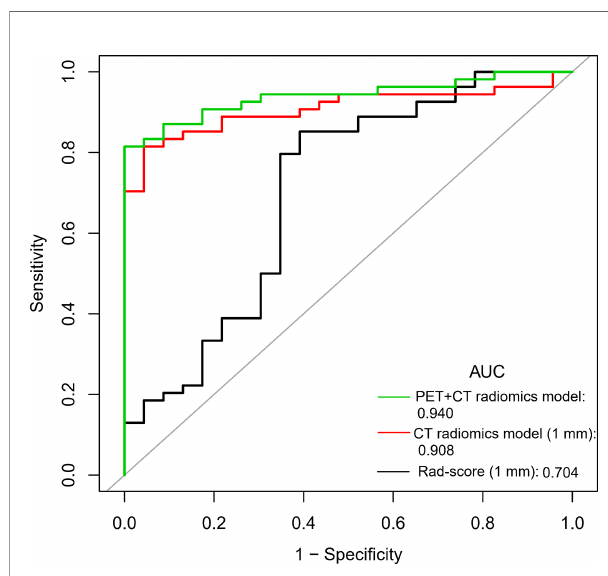
FIGURE 4 | Comparison of ROC curves of Rad-score, CT radiomics model, and PET + CT radiomics model of 1 mm